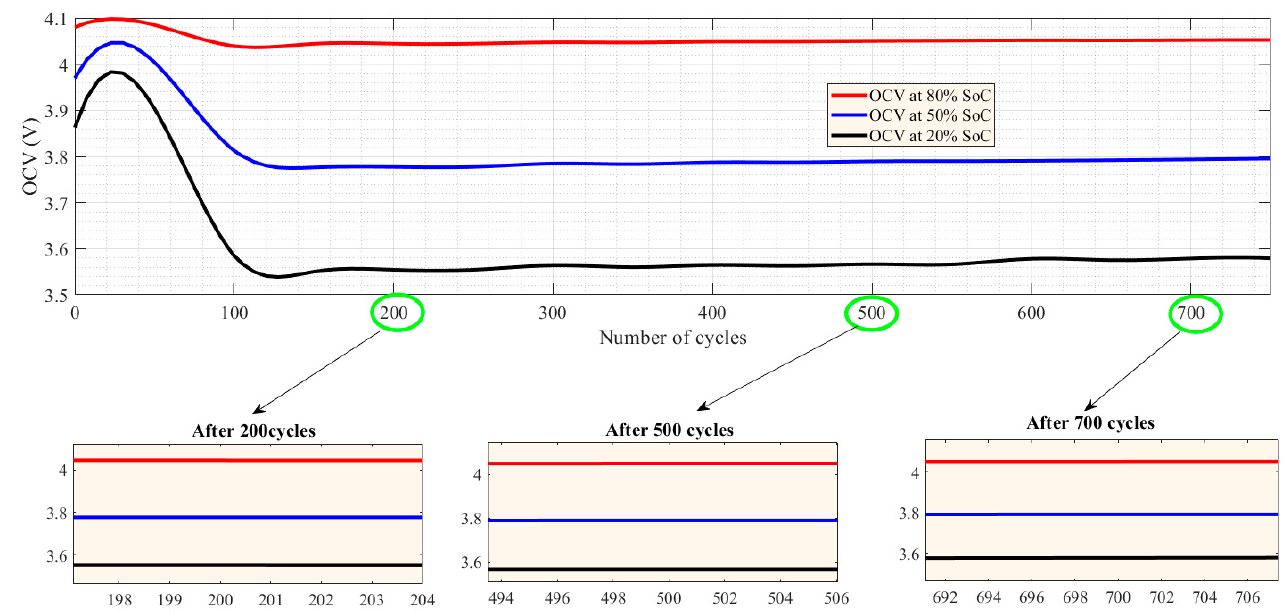
Figure 11. Comparison of the OCV pattern at 25 °C under C/2 charge and 2 C discharge test conditions.